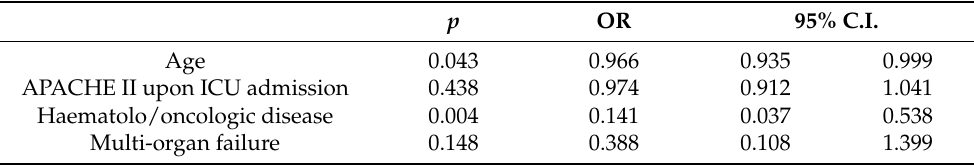
Table 3. Multivariate analysis for predictors of